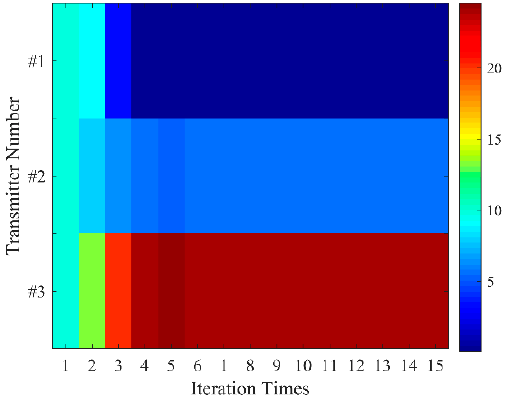
Figure 6. Power allocation results over 15 iterations.